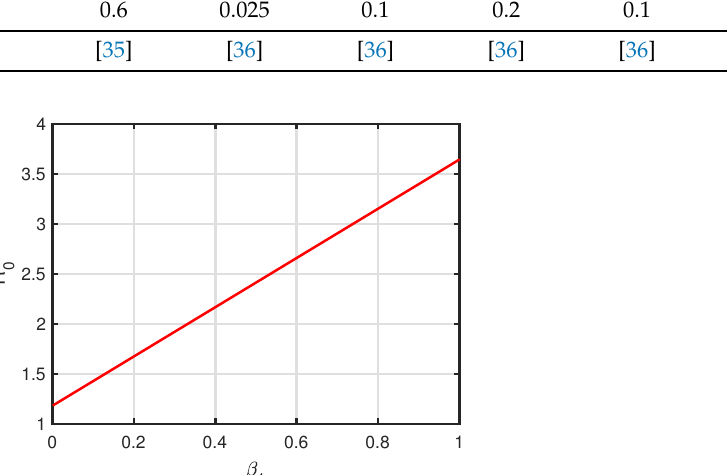
Figure 6. Variation of time series of system (3) with ε corresponds to Table 4 when R 0 = 2.2154. Table 6. Parametric values used in system (3) when β 1 < β 2 , E 1 = ( 0.051,0.0576,0.6081,0.0871 ) and R 0 = 1.4277. Parameters